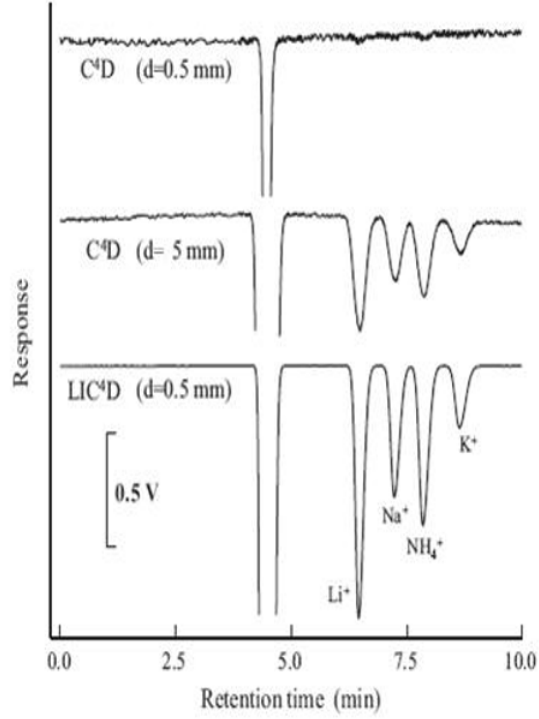
Figure 3. Chromatograms achieved with low capacitance C 4